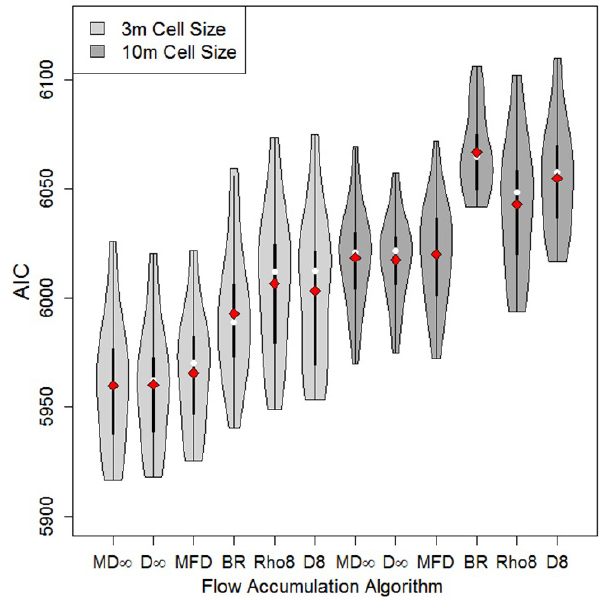
Figure 7. AIC values vs. flow accumulation algorithm for both the 3 (light grey) and 10m (dark grey) lidar data